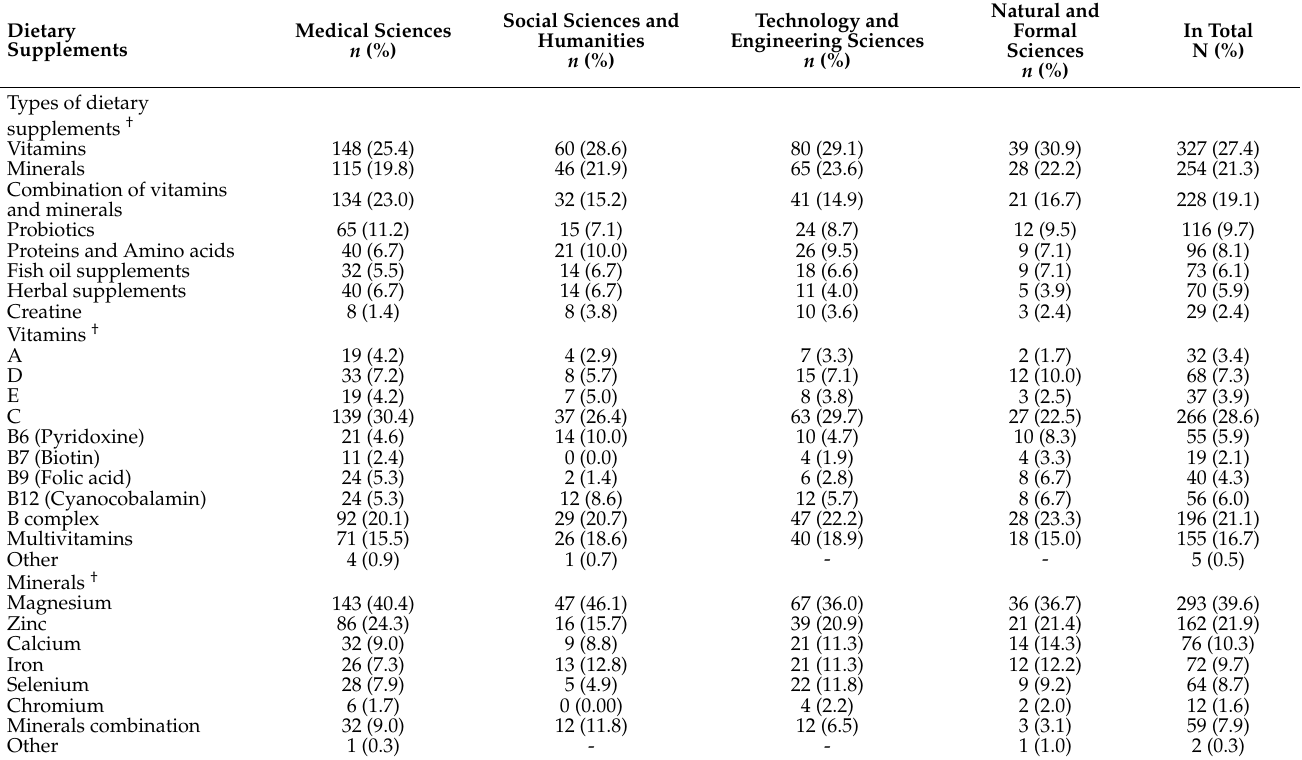
Table 4. The most common types of dietary supplements, vitamins, and minerals used among